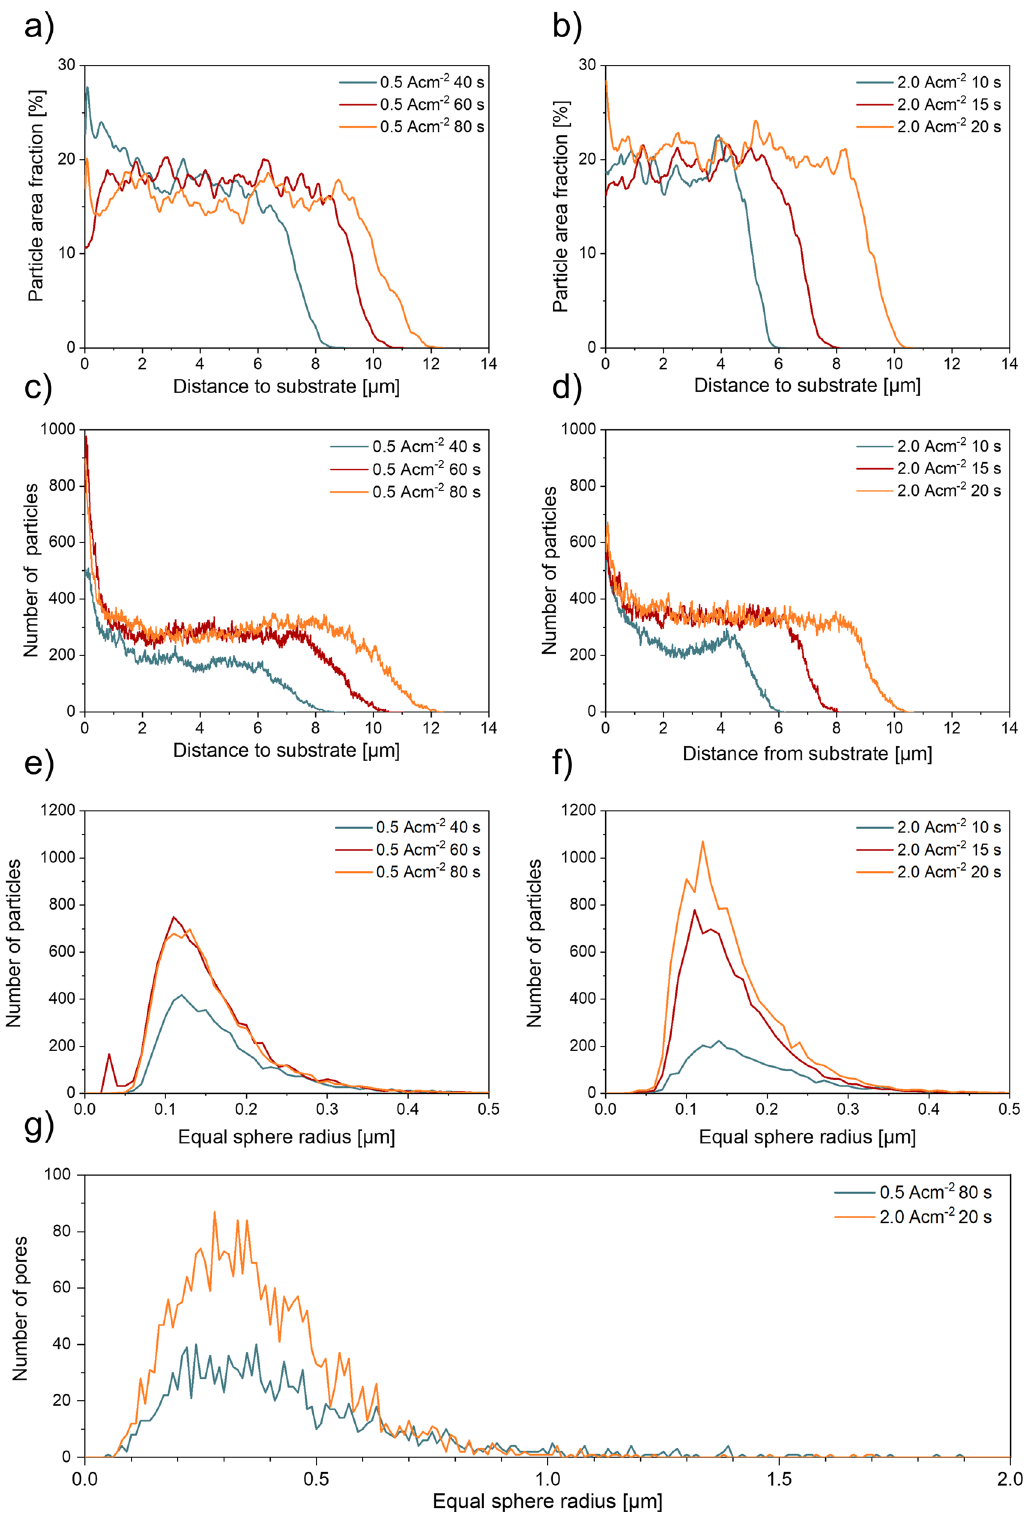
Fig. 9 Morphological characteristics of the nano-porous foam walls. Graphs a and b show the Ag particle area fraction in dependence on their distance to the Ag foil substrate deposited with 0.5 Acm − 2 and 2.0 Acm − 2 , c and d number of particles in dependence on the substrate distance of foams deposited with 0.5 Acm − 2 and 2.0 Acm − 2 , e and f equal sphere radius of foam particles deposited with 0.5 Acm − 2 and 2.0 Acm − 2 , g equal sphere radius of pores of the foams deposited with 0.5 Acm − 2 and 2.0 Acm − 2